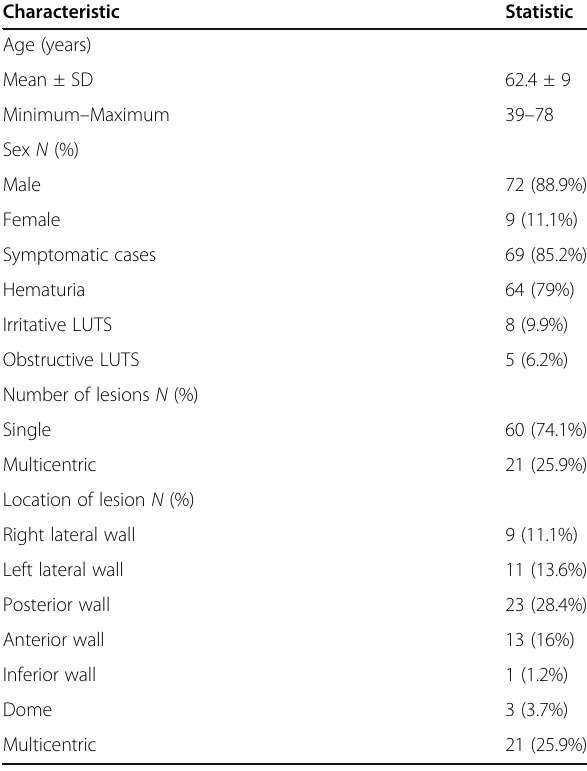
Table 3 Clinical characteristics of the study cohort ( N =